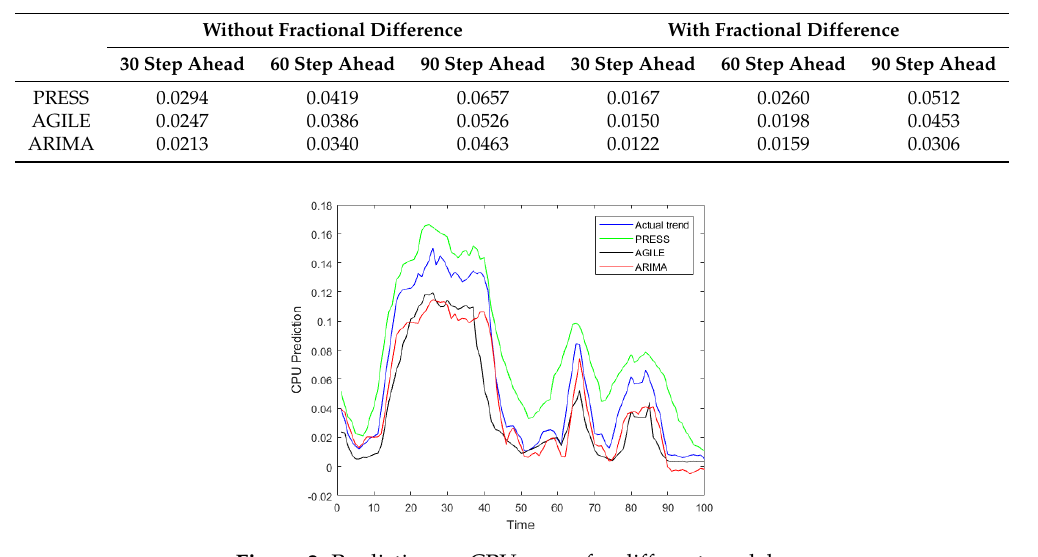
Figure 2. Prediction on CPU usage for different